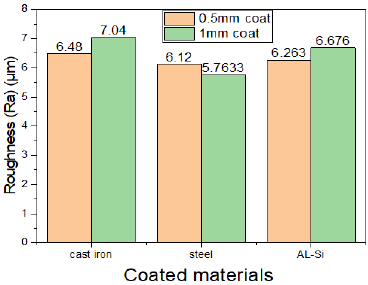
Figure 19: Coating roughness for different coating